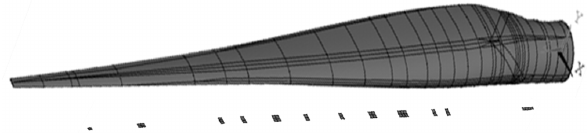
Figure 9. Finite element model of full blade.